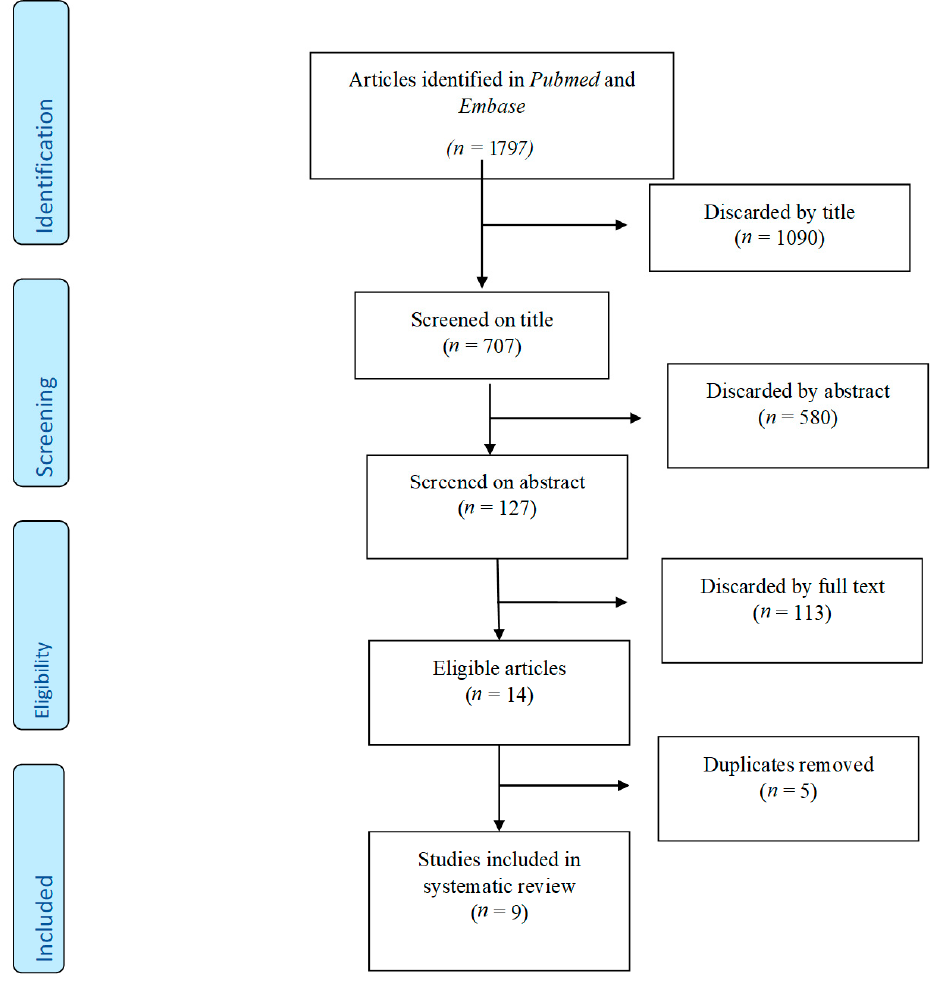
Figure 1. PRISMA flowchart.